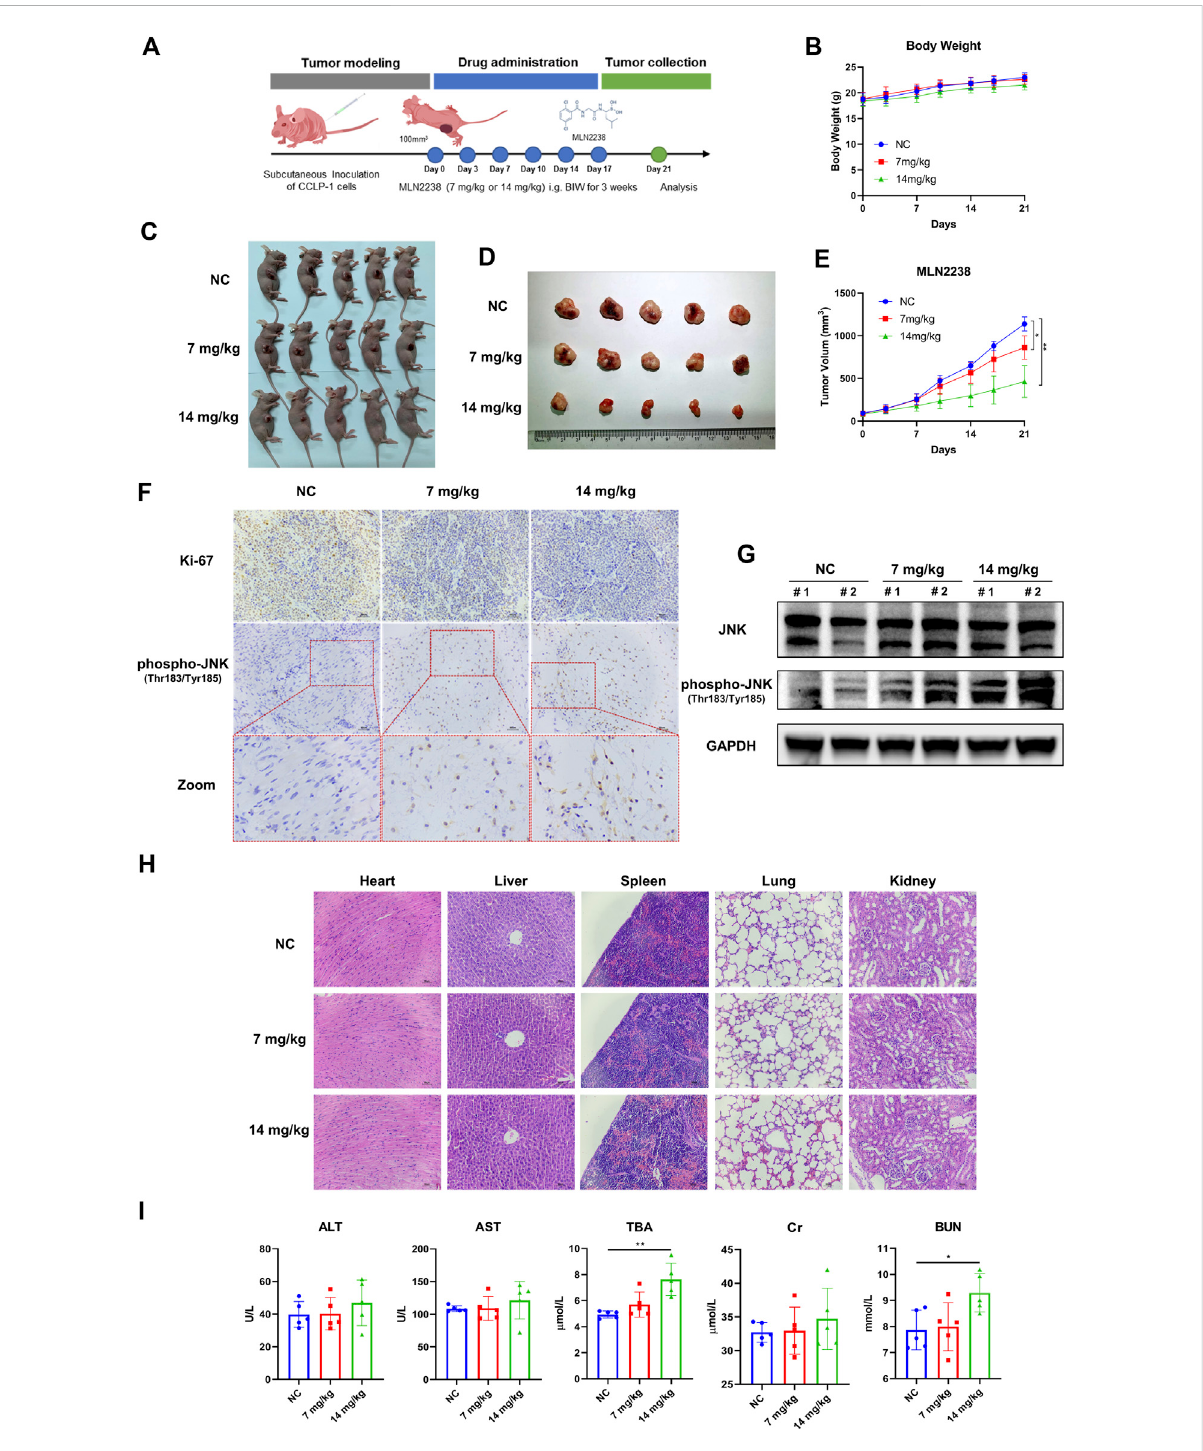
FIGURE 8 MLN2238 suppressed the tumor growth in the xenograft model of iCCA. (A) The scheme of iCCA xenograft model construction and MLN2238 administration in vivo . (B) The body weight of tumor-bearing mice after MLN2238 treatment during the experiment. (C,D) The images show the unresected and resected xenograft iCCA for each group. (E) The tumor volumes after MLN2238 (7 mg/kg or 14 mg/kg) treatment were calculated twiceaweekduring theexperiment. (F) TheKi-67 andimmunohistochemistryassays ofphospho-JNK(Thr183/Tyr185)forxenograft iCCA. (G) The protein expression levels of JNK and phospho-JNK(Thr183/Tyr185) in tumor tissues were analyzed via Western Blotting. (H) The H&E stains ofheart,liver, spleen,lungand kidney tissuesoftumor-bearing miceafter differentMLN2238 concentrations treatment wereusedto evaluate the biosafety. (I) The serum ALT, AST, TBA, Cr and BUN were detected after MLN2238 treatment at the end of the